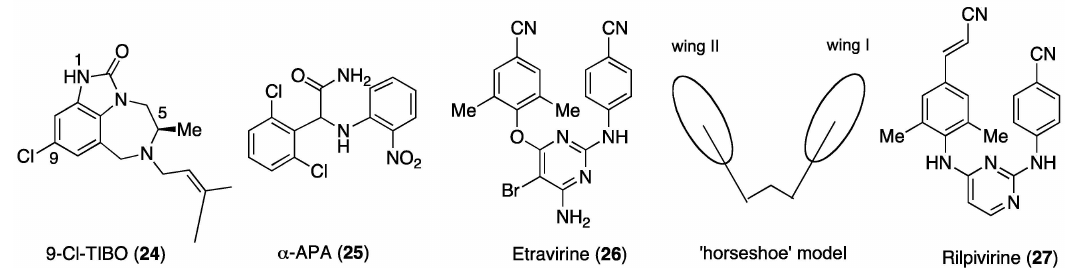
Scheme 7. Structure of tetrahydro-imidazo-benzodiazepin-one (TIBO), α -anilino-phenyl-acetamide ( α -APA), Etravirine (ETR) and Rilpivirine (RPV), and horseshoe